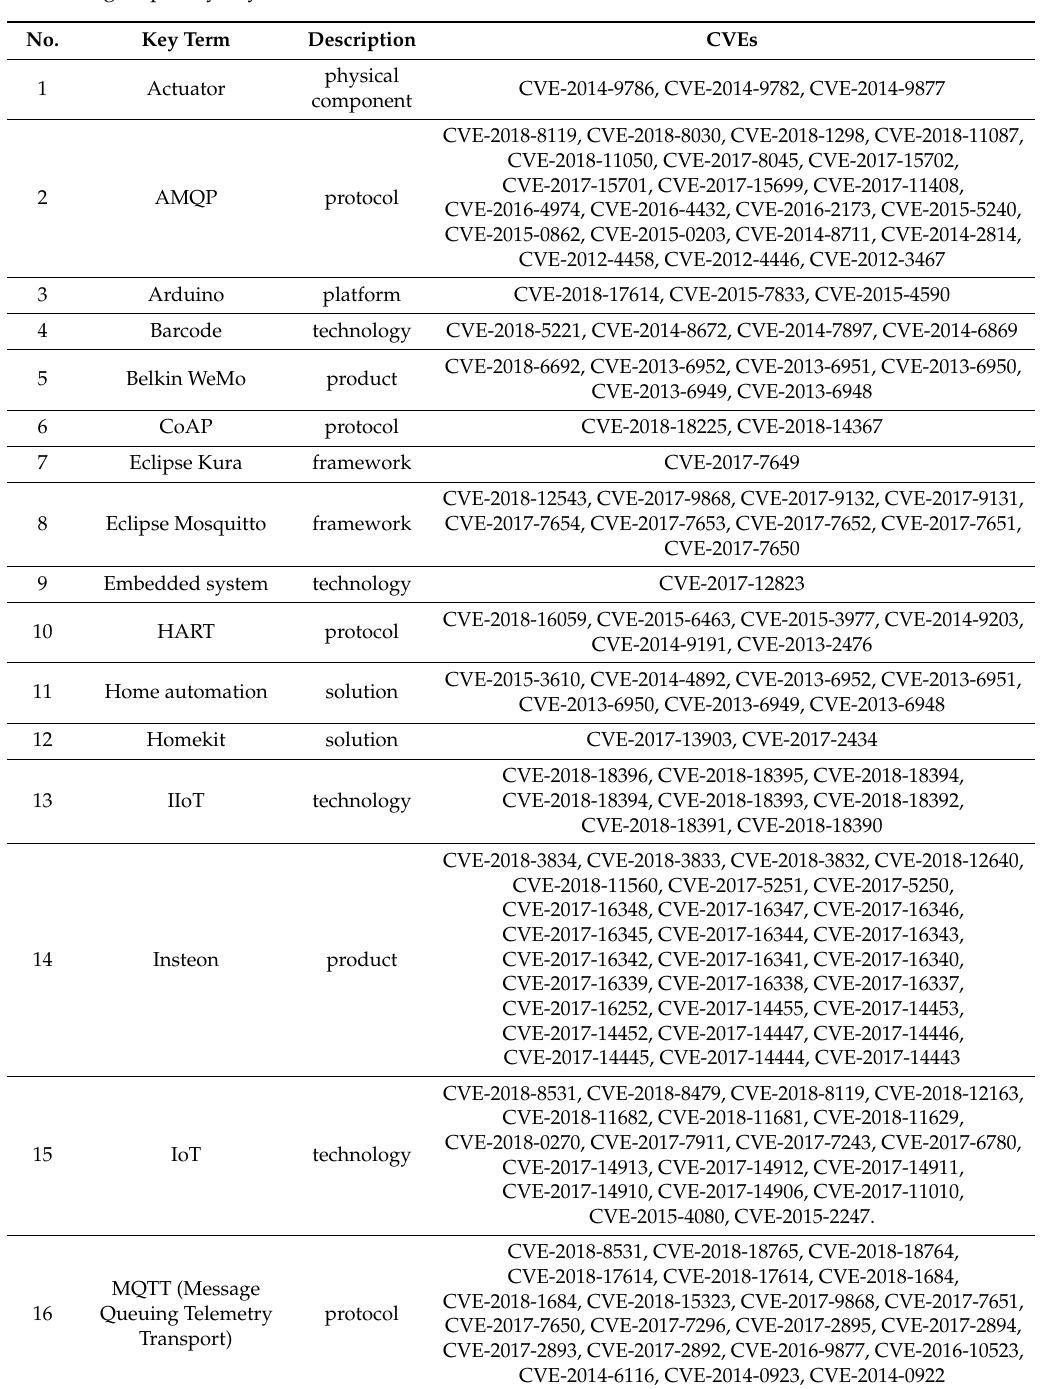
Table A1. Common vulnerabilities and exposures (CVEs) relevant for the Internet of Things (IoT) domain grouped by key